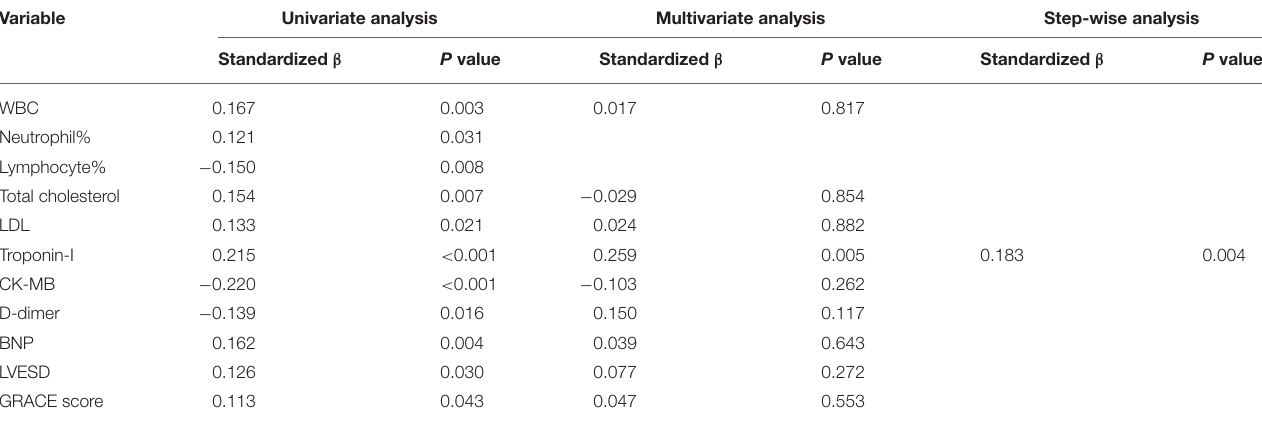
TABLE 3 | Univariate and multivariate linear regression models for TSLP.